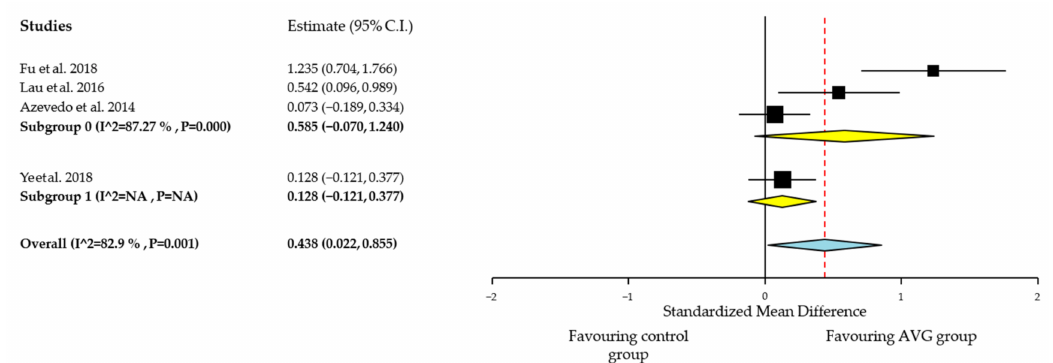
Figure 3. Cardiorespiratory fitness effect sizes for AVG compared with control group. Analysis by control group; Subgroup 1: control group with no intervention; Subgroup 2: exercise control